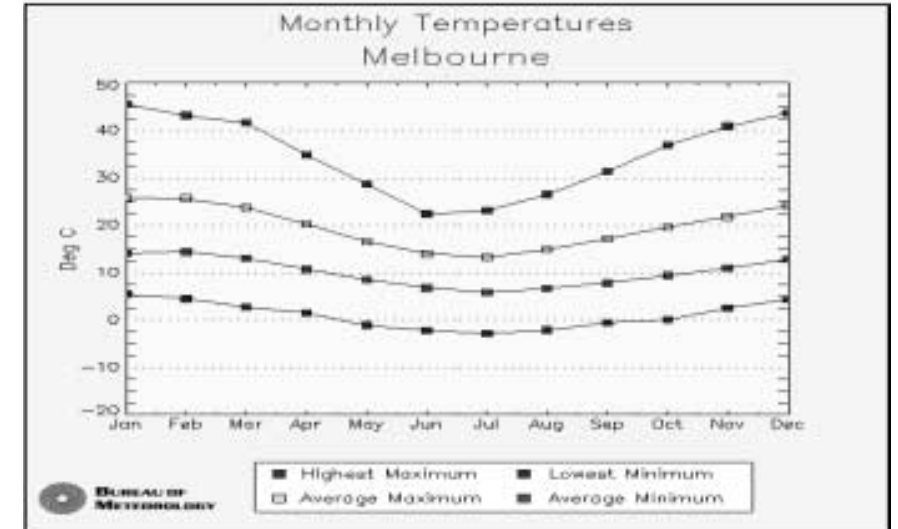
Figure 3. Monthly temperature extremes for Melbourne Melbourne enjoys a pleasant maritime temperate climate with warm summers and chilly winters. Summers have very few hot days with respite coming from cooler evenings and 7 to 9 days of rain each month. Winter brings some frost but no snow and ice. Winter temperatures can drop 2 to 5 degrees Celsius over night. There are about 10 to 16 days of rain bringing 50–60 mm of rain each month. Figure 3 shows the average monthly temperature as recorded by the Bureau of Meteorology for 1999 (BOM, 1999a). The chart shows that the highest temperatures occur in December-January while the lowest are in June-July. Small variations in the monthly minimum temperatures and large variations in the maximum temperatures mean that summer months can still be cold while winter months are rarely very warm. This difference has special significance in the emission of carbon monoxide, volatile organic compounds and particulates and in the production of ozone and